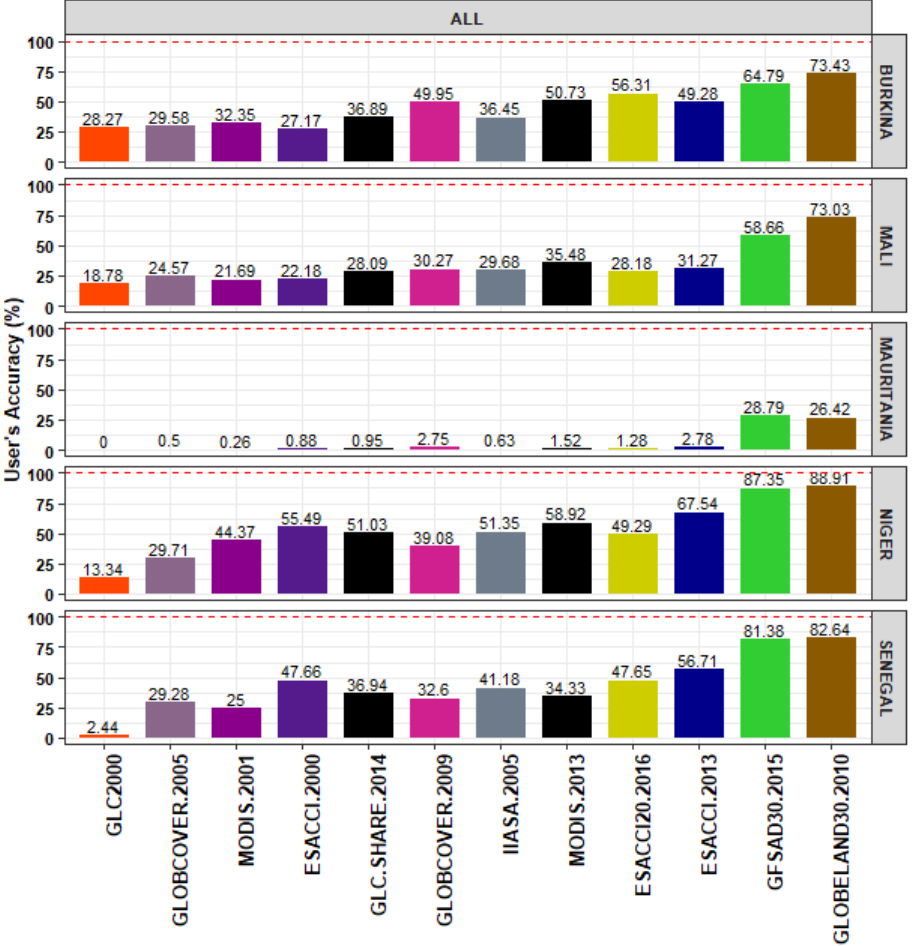
Figure 4. User’s accuracy of the “all crop” class by country and land cover Figure 4 . User ’ s accuracy of the “all c rop ” class by country and land cover product.